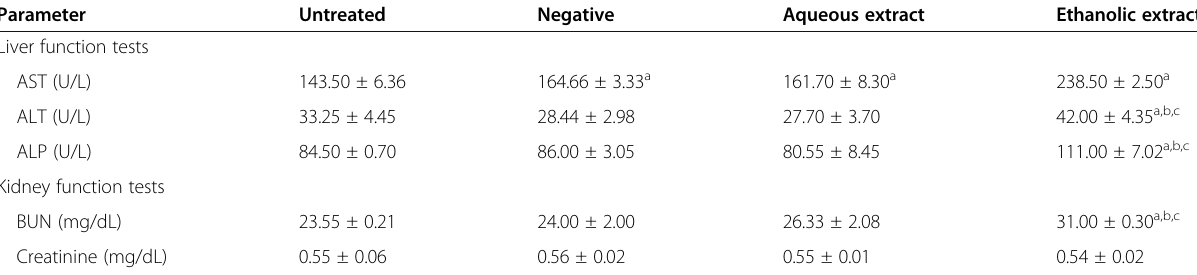
Table 7 Liver and kidney biochemical analyses of the untreated, negative control and aqueous and ethanolic extract groups during acute toxicity